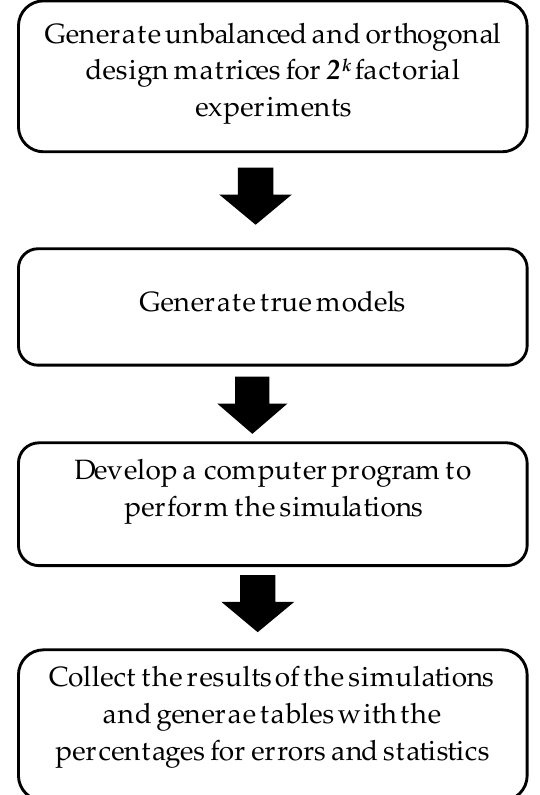
Figure 2. Research Figure 2. Research method.